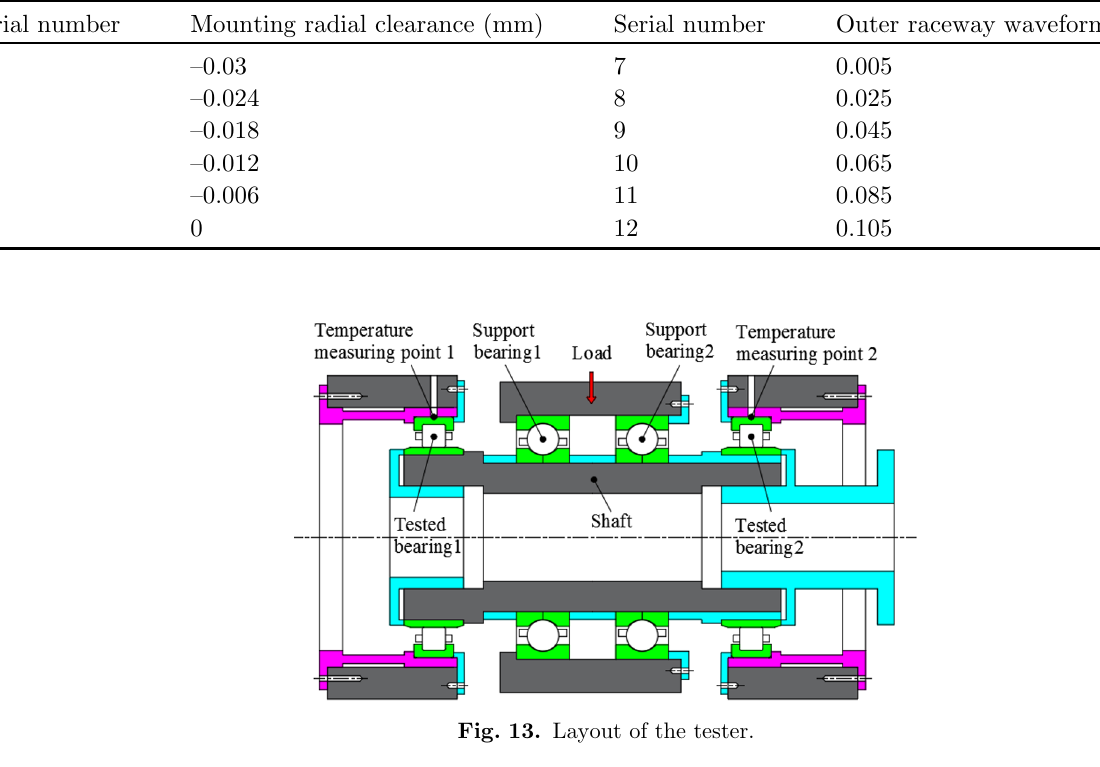
Table 4. Variable parameters of the test bearing.